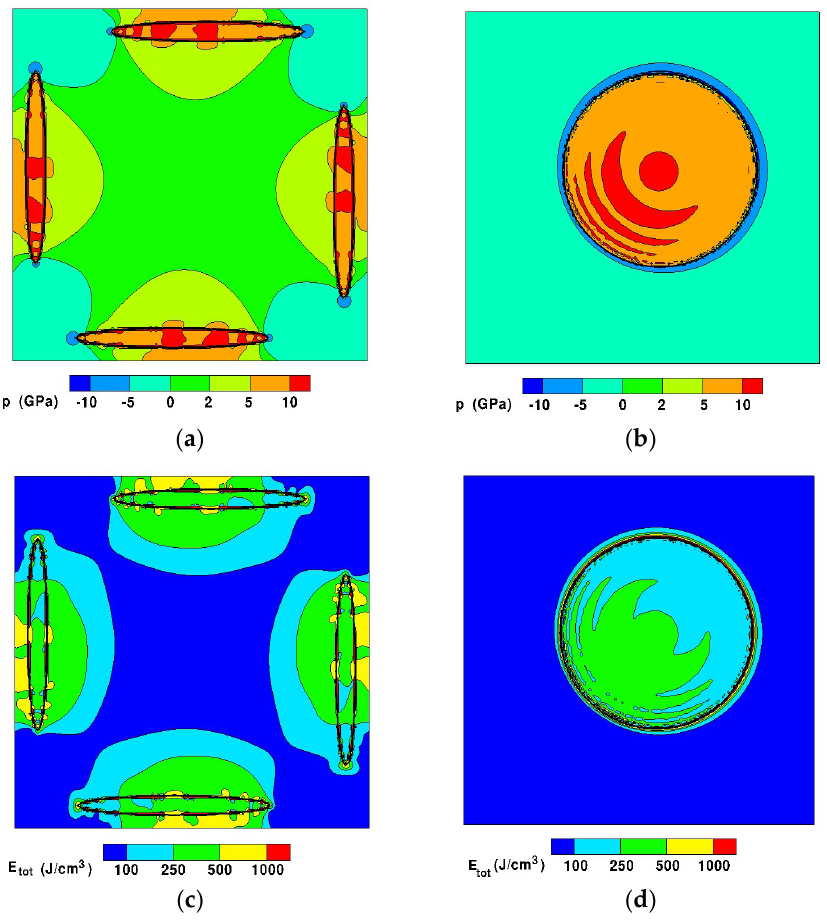
Figure 12. Results of mechanical calculations for a 5% volume fraction of precipitates. ( a ) Pressure map in plane (X = 0.5; Y; Z); ( b ) Pressure map in plane (X = 0.065; Y; Z); ( c ) Total elastic strain energy map in plane (X = 0.5; Y; Z); ( d ) Total elastic strain energy map in plane (X = 0.065; Y; Z).